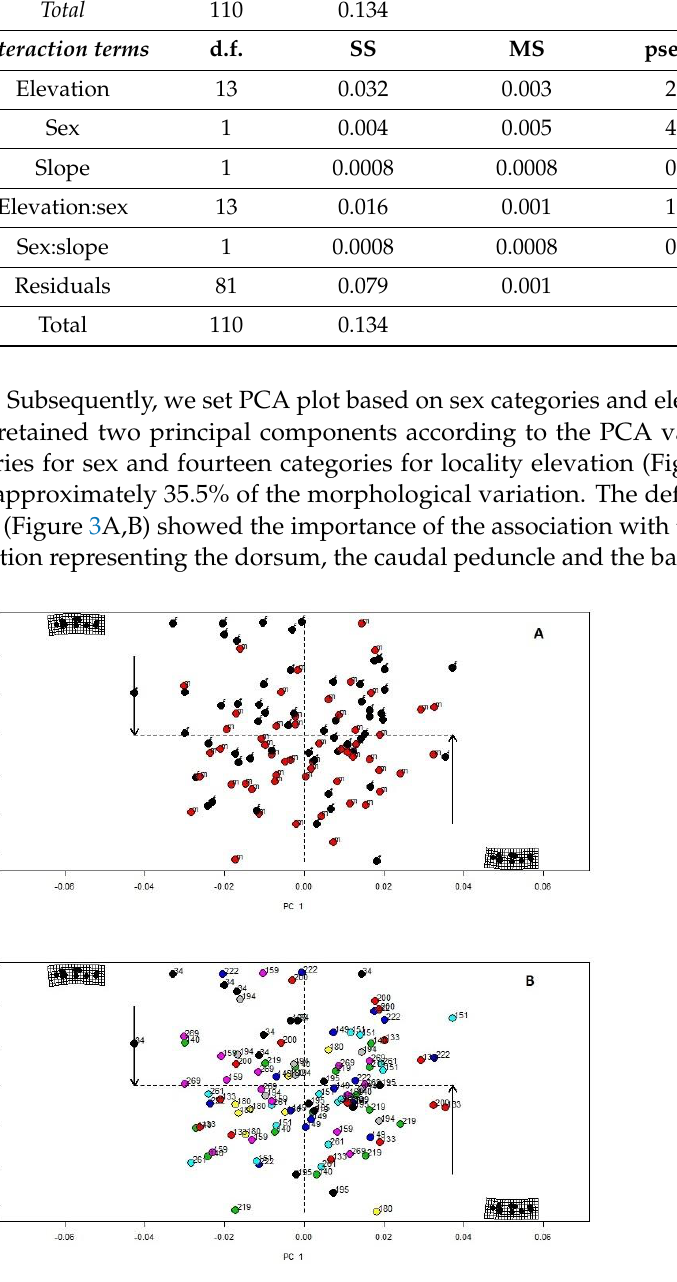
Table 2. Morphometric variance of 111 individuals of Sabanejewia spp. within the groups and pair- wise comparisons of group variances (two ways) based on elevation of the localities listed in Table S1. Elevation in m a.s.l.